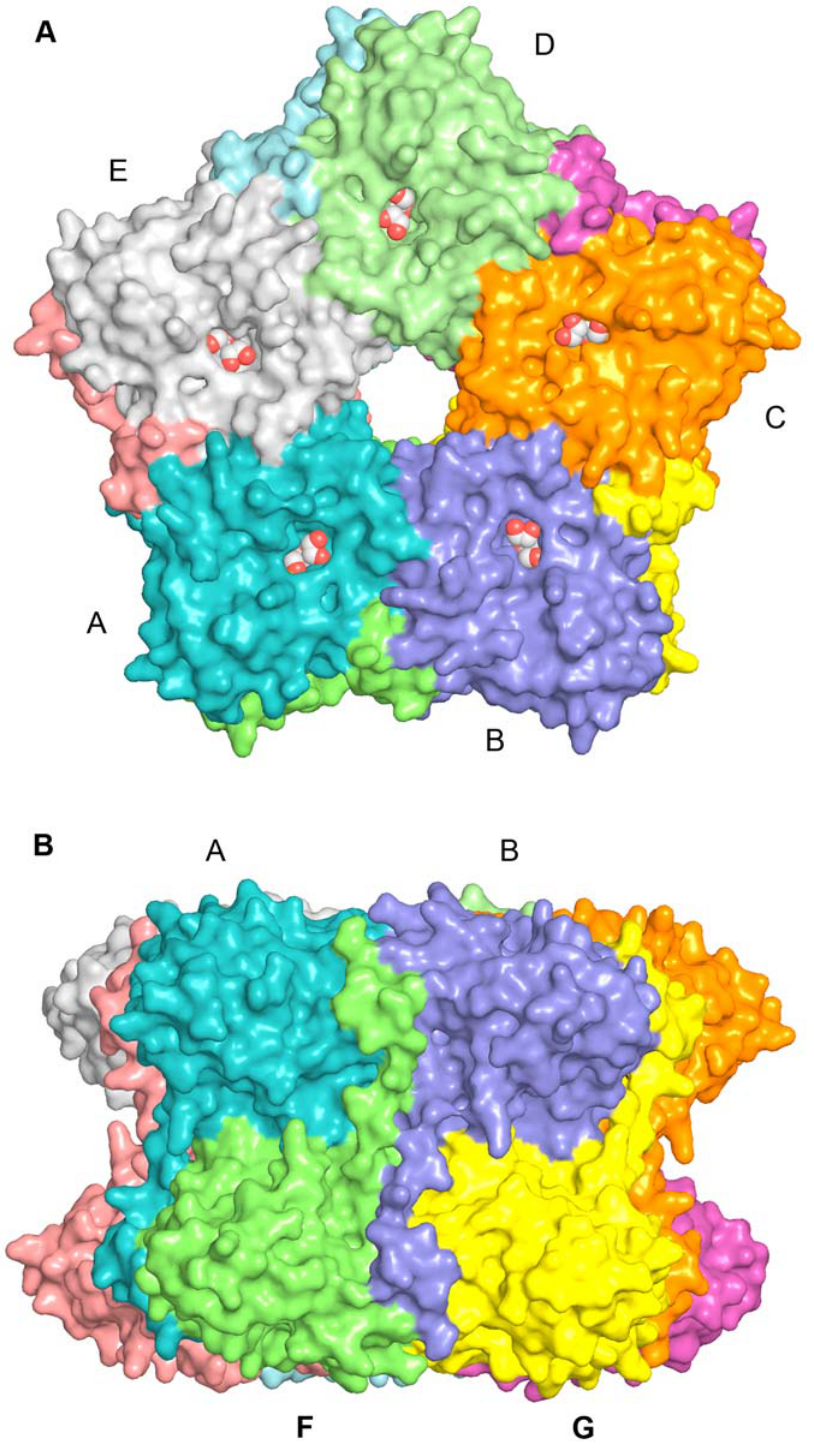
Figure 3. Structure of the LsrF decamer. A. Surface representation of the LsrF decamer, viewed down the 5-fold symmetry axis, with each monomer a different color. The bound ligand (ribose-5-phosphate) is visible in the center of the ( ab ) 8 -barrel, and is shown in ball-and-stick format. B. Perpendicular view of the LsrF decamer along a two-fold axis. doi:10.1371/journal.pone.0006820.g003 R5P and 5RP bind LsrF in the same location, near the entrance to positively charged side chain of Arg254 and is positioned to form the ( ab ) 8 -barrel with the phosphate group oriented towards the coils hydrogen bonds with the side chain of His58, the side chain and following b 7 and b 8 (Fig. 2a & c). The phosphate is located near the main chain of Arg254, and the main chain of three glycine residues: